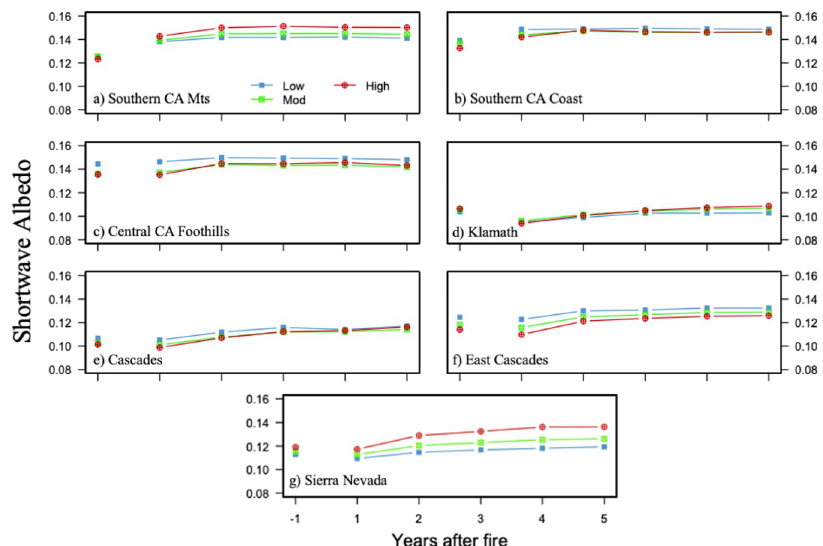
Fig 6. Prefire albedo and five-year early-summer postfire trajectory (a-g). Average early-summer surface shortwave albedo response for the first-year pre-fire through five-years post-fire for each ecoregion SCM, SCC, CCF, K, C, EC, and SN. Prefire and postfire albedo are burned area averages.